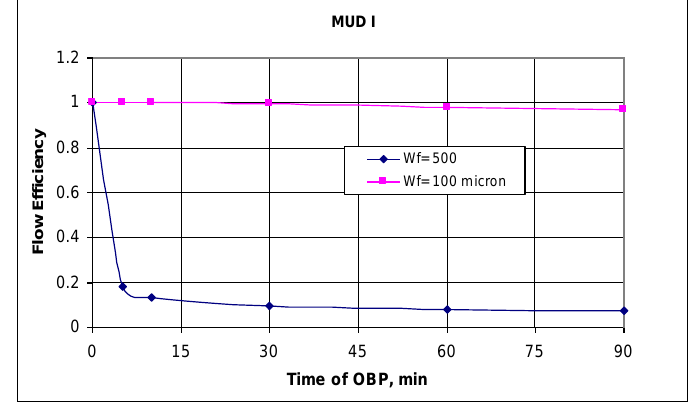
Figure 5. Analytical model results-the flow efficiency vs. time of OBP, for two rock systems. MUD I